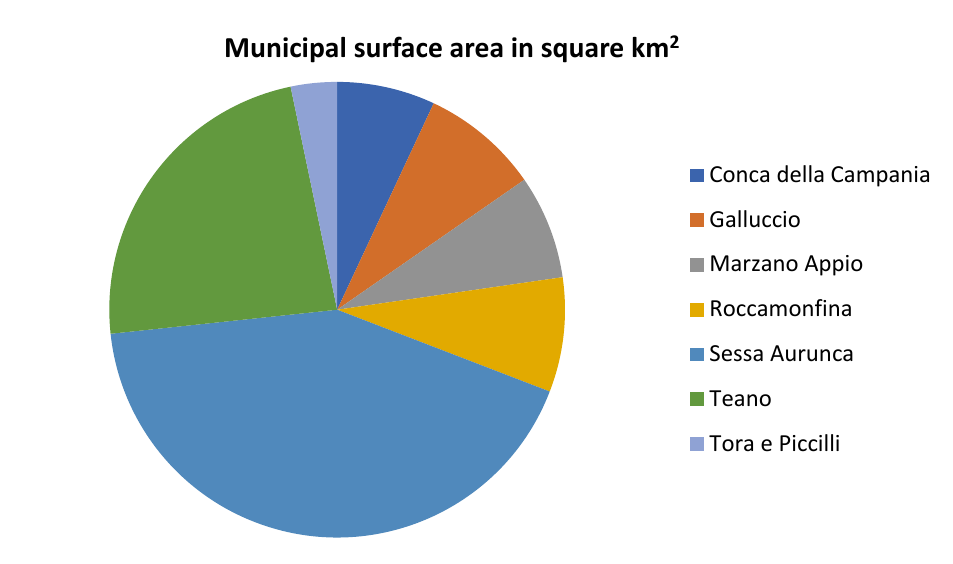
Figure 5. The municipal surface area is represented in square kilometres of the municipalities included in the Regional Park of the volcanic area of Roccamonfina and the mouth of Garigliano (elaboration by Antonio Bertini on Istat data).